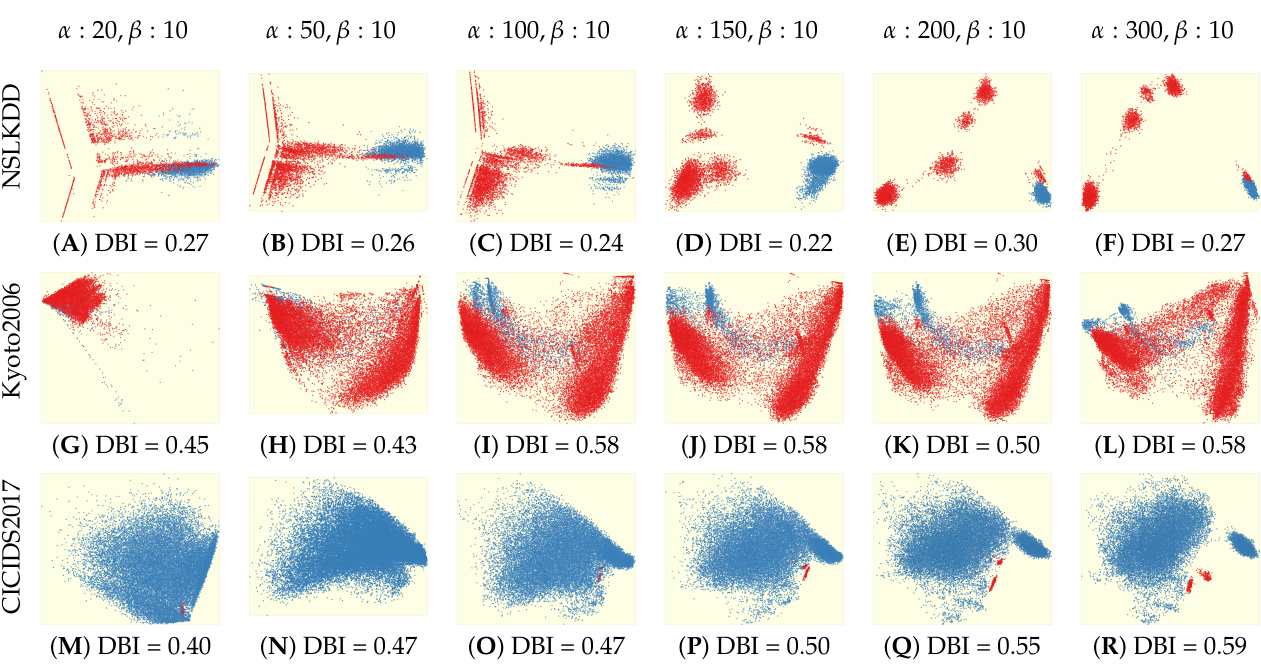
Figure 3. Visual representations of the conducted empirical study of identifying optimal parameters with different sliding window sizes ( α ) with the wavelet function (Daubechies 3) to detect network intrusions. DBI indicates the Davies–Bouldin